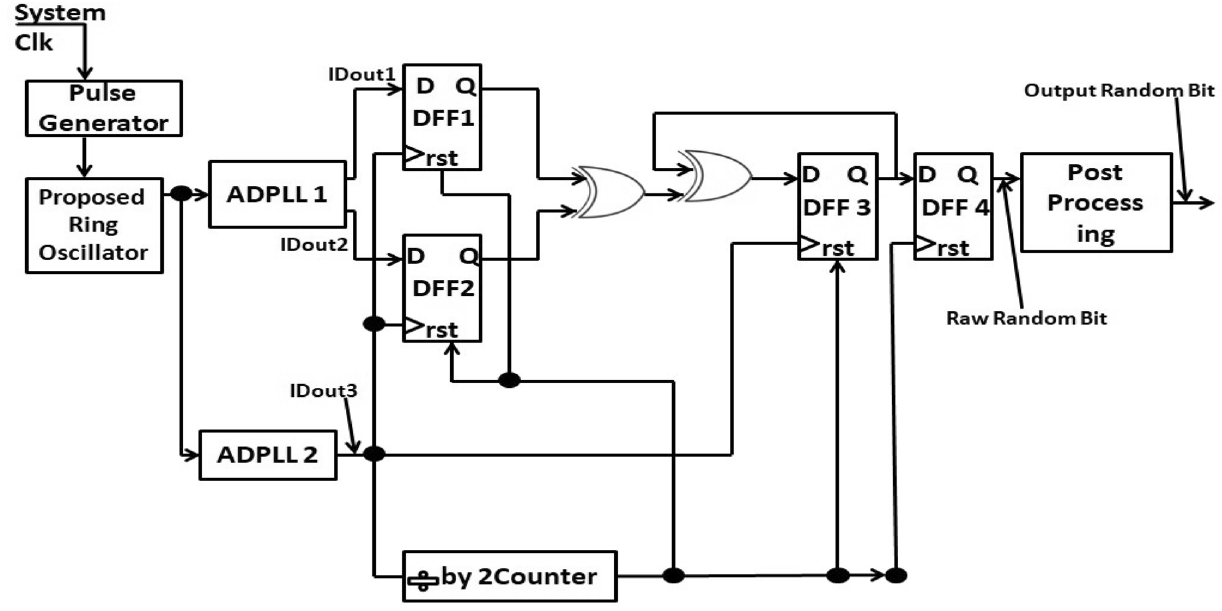
Fig. 11 Block diagram of FAT-2 TRNG